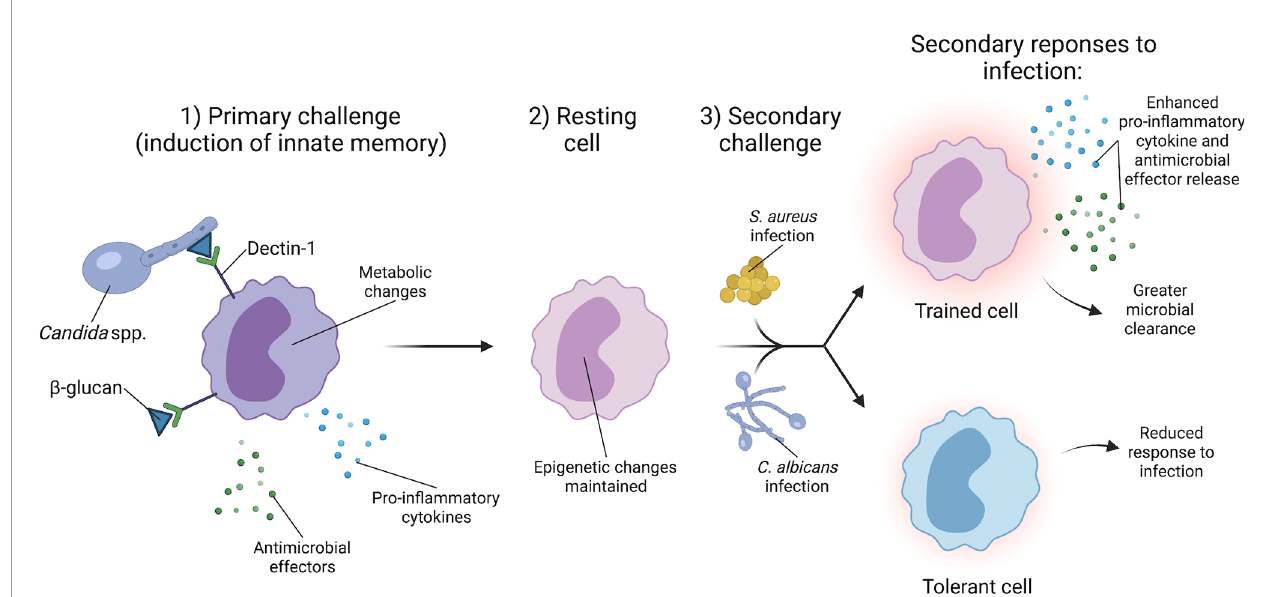
FIGURE 3 | C. albicans induces innate immune training to provide broad protection against secondary infections. The generation of innate immune memory is dependent upon C. albicans cell wall component b -glucan signaling through Dectin-1 on monocytes. Dectin-1 signaling induces epigenetic changes and a metabolic shift from oxidative phosphorylation to aerobic glycolysis. Upon clearance of the primary C. albicans infection, monocytes enter a resting state, but retain the epigenetic changes from the primary challenge. Secondary challenge with a lethal infection of C. albicans or other organisms such as S. aureus causes the trained monocyte to produce a robust immune response that facilitates greater clearance of secondary S. aureus and C. albicans